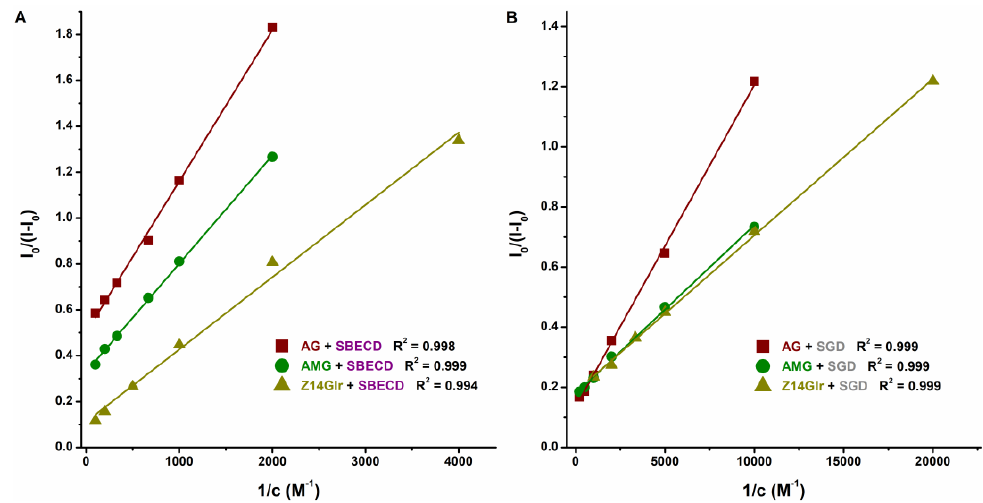
Figure 7. Benesi–Hildebrand plots of mycotoxin–SBECD ( A ) and mycotoxin–SGD ( B ) complexes (0.05 M sodium acetate buffer, pH 5.0; mycotoxins concentration: 1 μM; n = 3; λ ex = 335 nm for AG and AMG, and 315 nm for Z14Glr; λ em = 455 nm for each mycotoxin; AG, alternariol-3-glucoside; AMG, alternariol-9-monomethylether-3-glucoside; Z14Glr, zearalenone-14-glucuronide; SBECD, sulfobutylether- β -cyclodextrin; SGD, sugammadex). Table 4. Decimal logarithmic values of the binding constants ( K ; L/mol) of mycotoxin–cyclodextrin complexes, determined based on fluorescence spectroscopic studies ( n = 3).